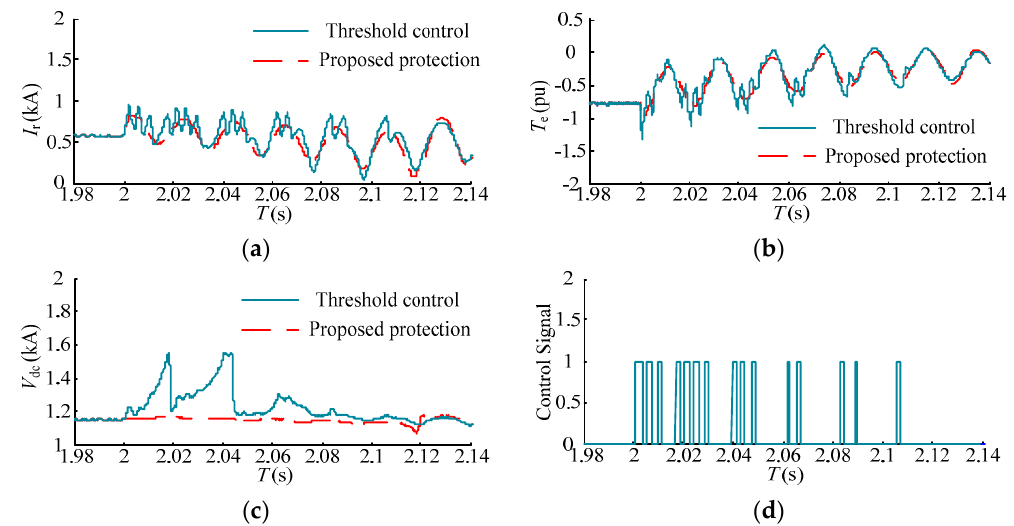
Figure 19. Comparisons between proposed protection and threshold control under a voltage sag of 0.8. ( a ) Rotor current; ( b ) electromagnetic torque; ( c ) DC-link bus voltage; and ( d ) the control signal of rotor braking resistor.